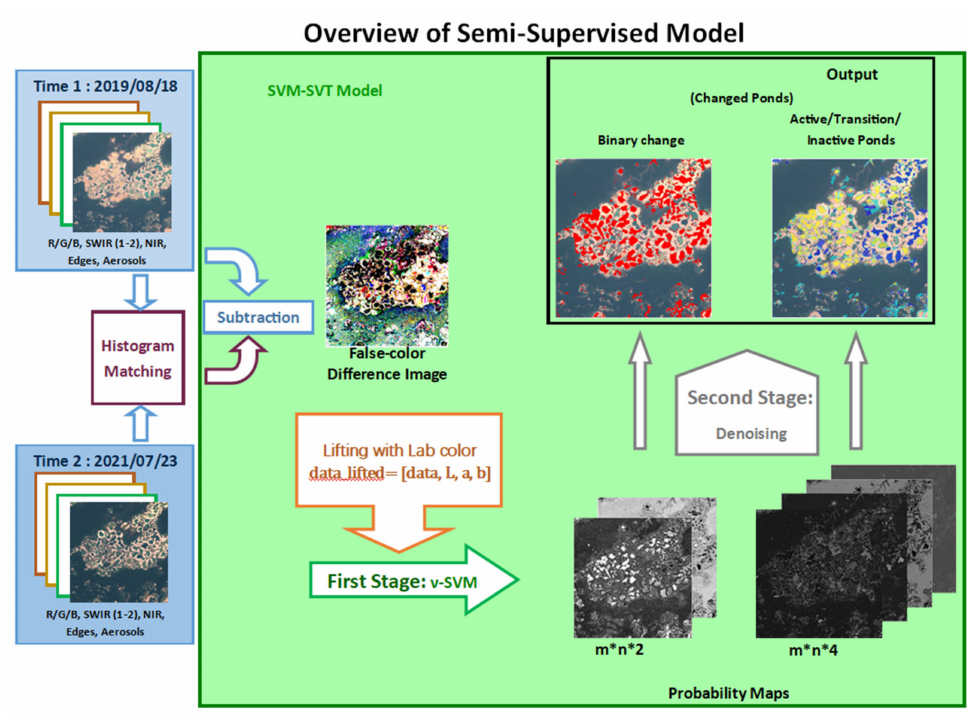
Figure 5. Overview of the SVM-STV method for mining change recognition. Bi-temporal images from a region were used as inputs. Preprocessing steps utilized histogram matching and lifting with lab color data for both images. Labeled points using different images were used to train the ν -SVM in the first stage and then used to generate probability maps. In the second stage, spatial information was utilized by denoising the probability tensor. The final classification results were obtained by taking the index of the maximum probability of each pixel to detect